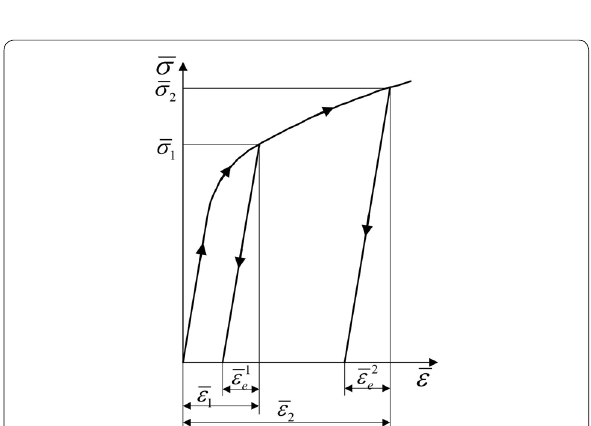
Figure 1 Equivalent stress-strain curve in elastic–plastic deformation and springback